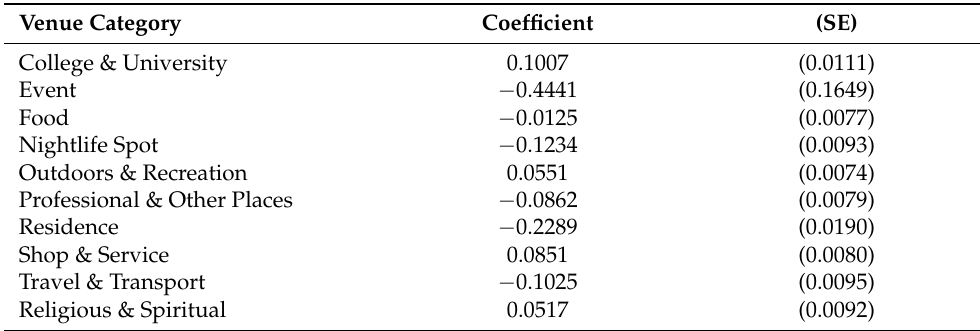
Table 2. Multinomial model with urbanity as